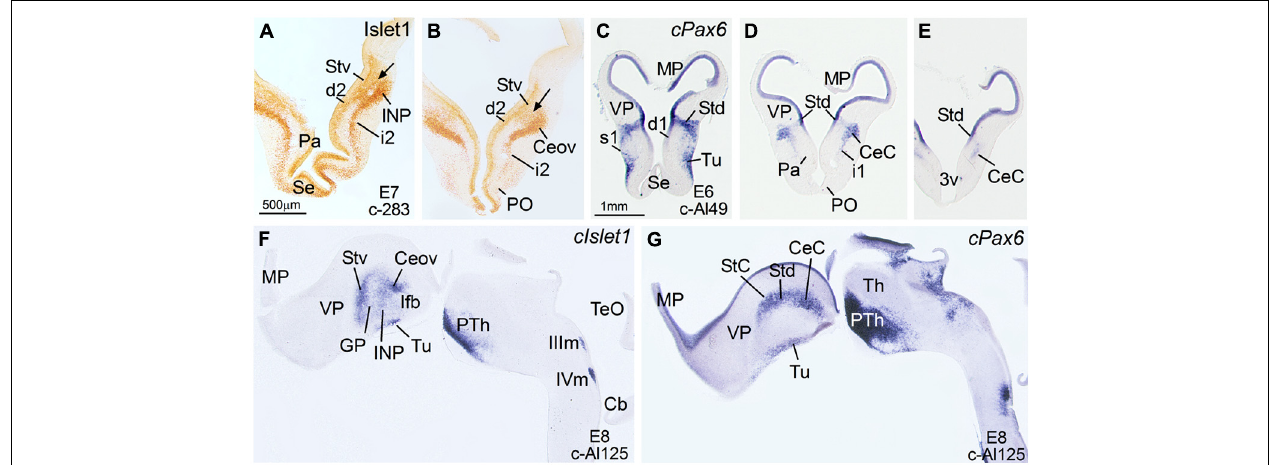
s refer to deep, intermediate or superficial stream of cells that apparently are migrating tangentially from Stv (Islet1-expressing cells; d2, i2) or Std ( cPax6 -expressing cells; d1, i1, s1) toward more ventral areas of the subpallium.The Islet1 cells of Ceov appear to migrate ventralwards through the caudal aspects of i2. See text for more details. (F,G) : Sagittal sections of a E8 chicken brain, at the levels of Ceov and CeC, hybridized for cIslet1 , or cPax6 . For abbreviations, see list. Scale bars: A = 500 μ m (applies to A,B ); C = 1 mm (applies to C–G